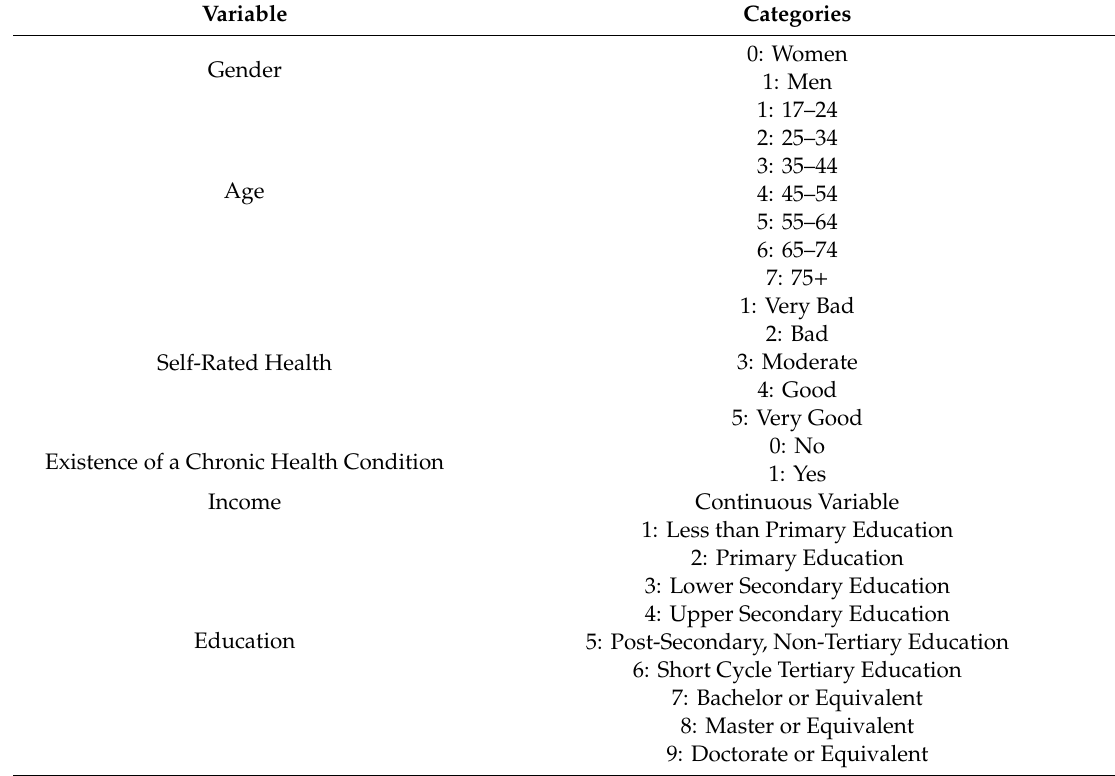
Table 2. Potential predictors (2nd